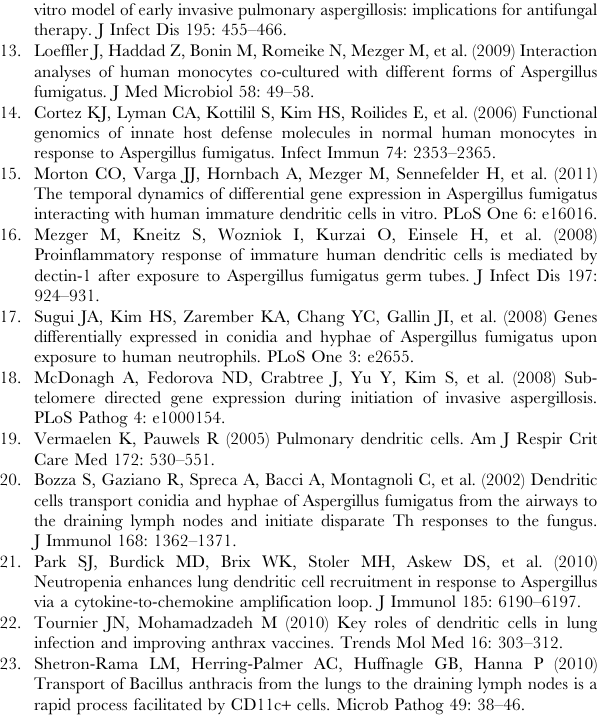
Table S1 Gene Ontology Analysis of A549 cells